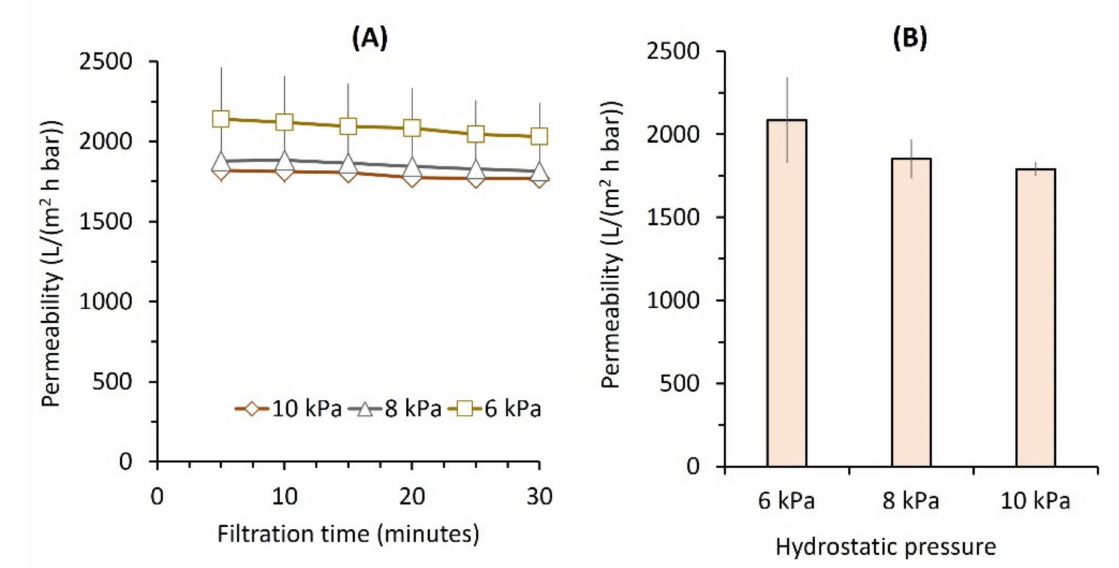
Figure 2. Clean water permeability as a function of applied pressure shown ( A ) over time and ( B ) the final